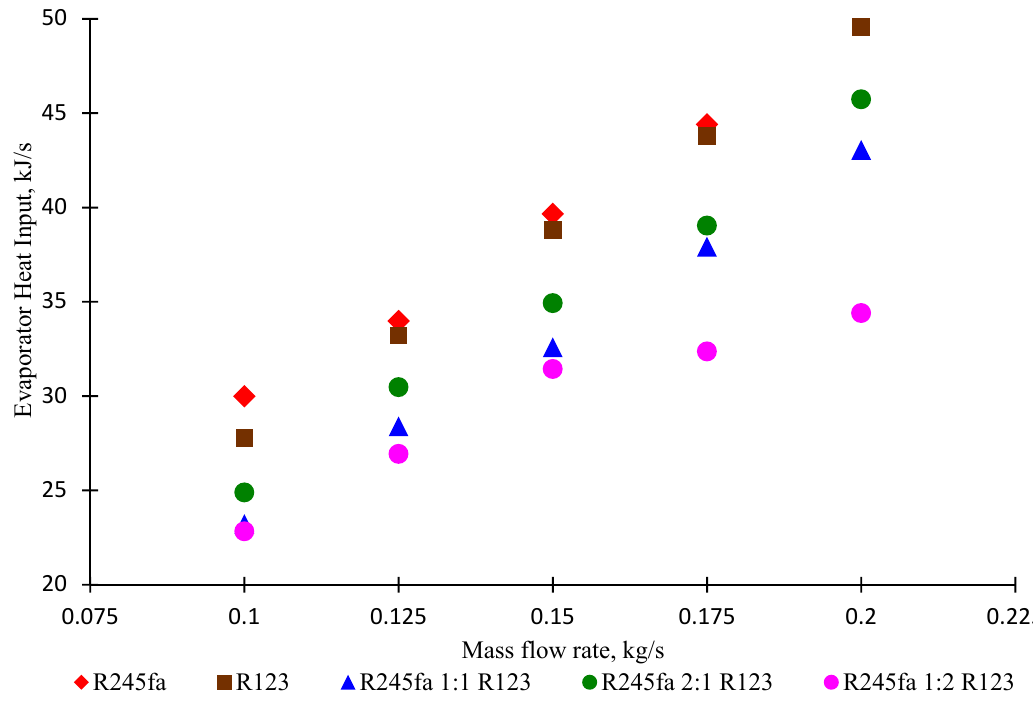
Figure 11. Evaporator heat input as a function mass flow rate for R245fa, R123, and mixed working fluids with heat source at 110 ° C .